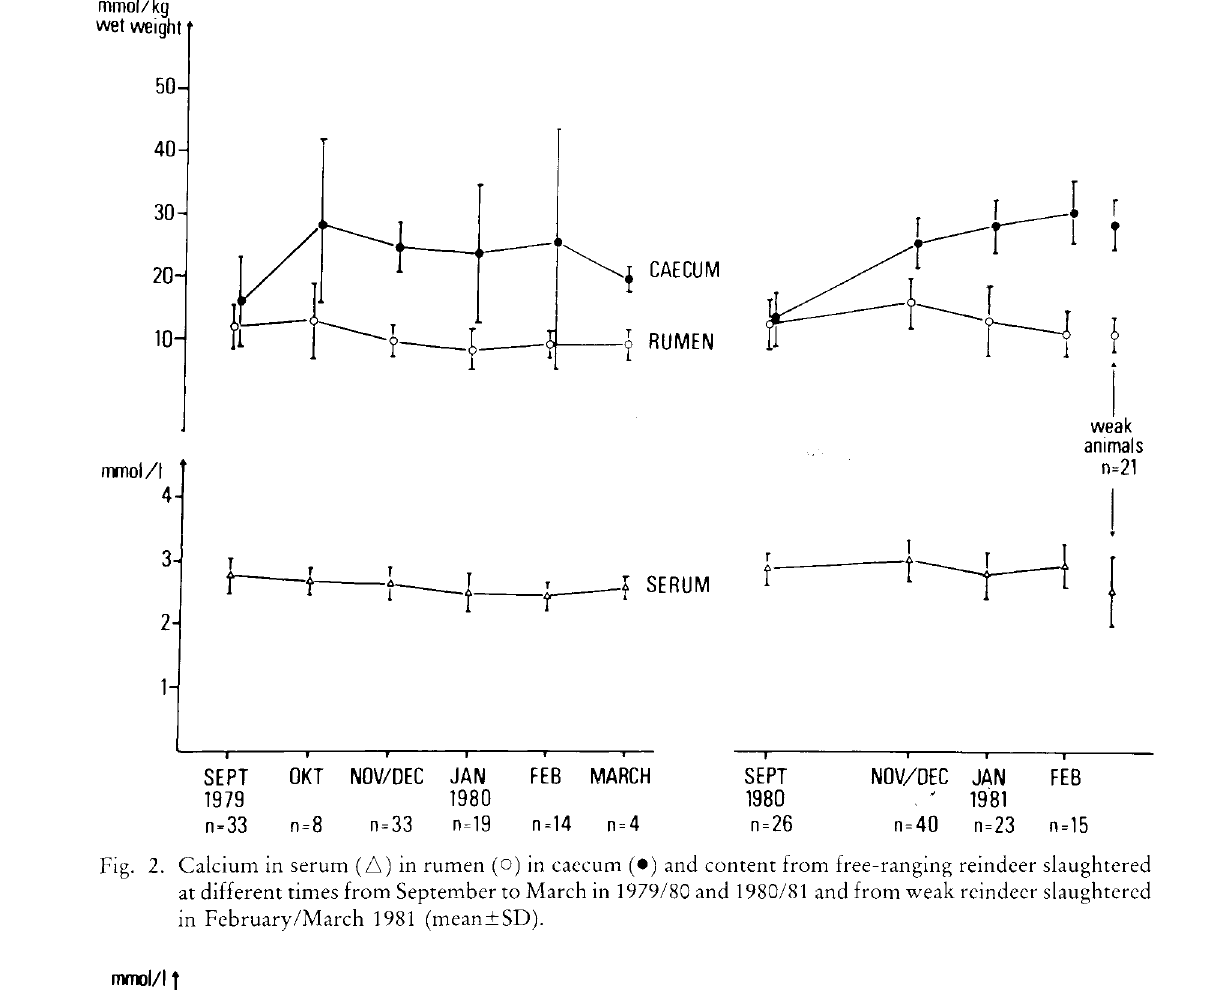
Fig. 2. Calcium in serum (A) in rumen (o) in caecum (•) and content from free-ranging reindeer slaughtered at different times from September to March in 1979/80 and 1980/81 and from weak reindeer slaughtered in February/March 1981 (mean±SD).